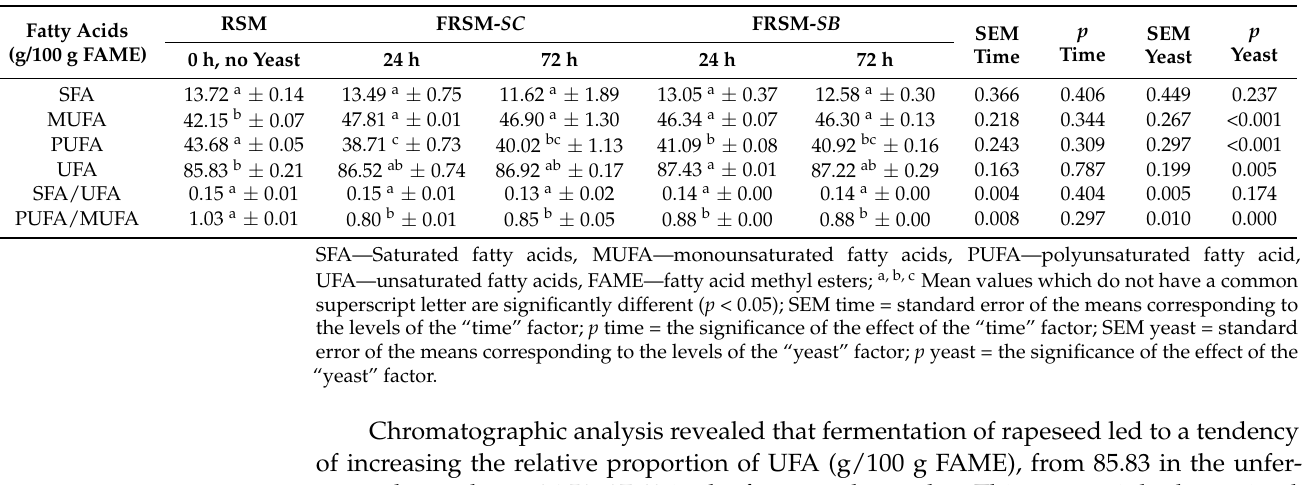
Table 7. Fatty acids content in rapeseed